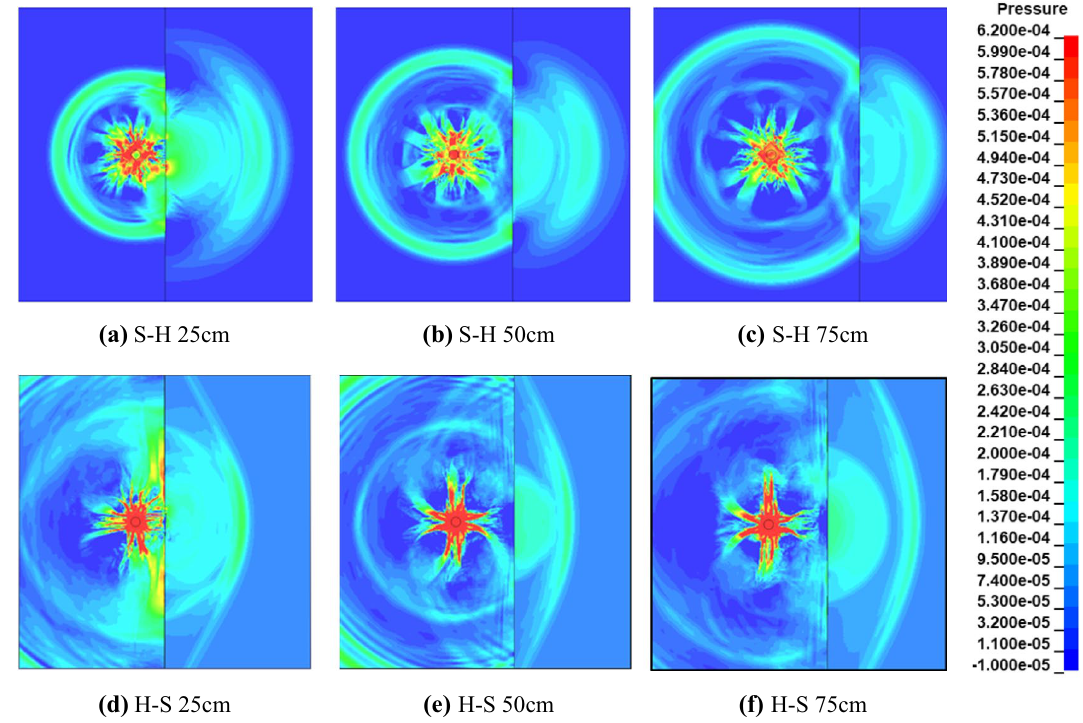
Figure 12. Stress cloud diagram of single-hole blasting model of composite rock formation.